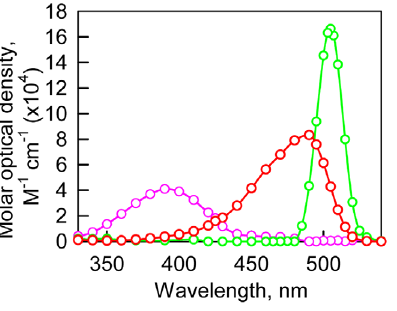
Figure 5. The change of the ratio of A l i , j ð Þ = A l i , 0 ð Þ . The dependences calculated on the base of absorption spectra of sfGFP in the buffered solution and in the presence of 0.02, 0.05, 0.1, 0.2 and 0.4 M GTC are shown.